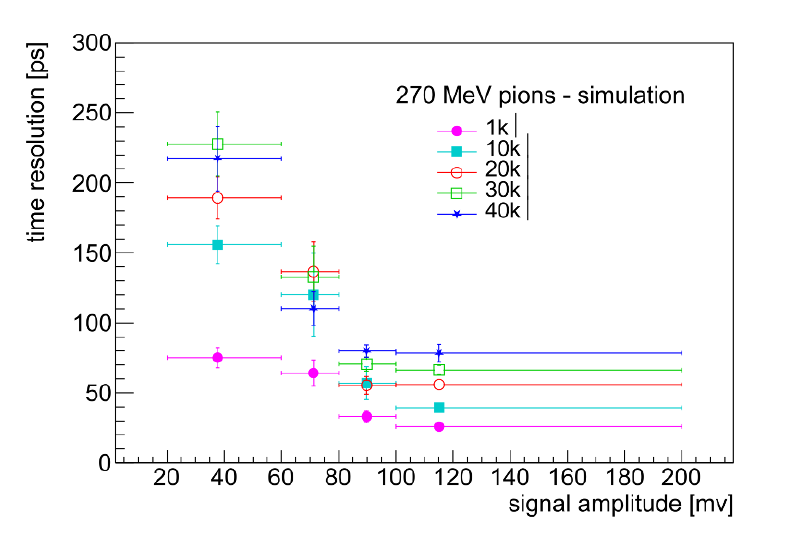
Figure 15. Time resolution as a function of signal amplitude for simulated 270 MeV pions, for different values of the electrode